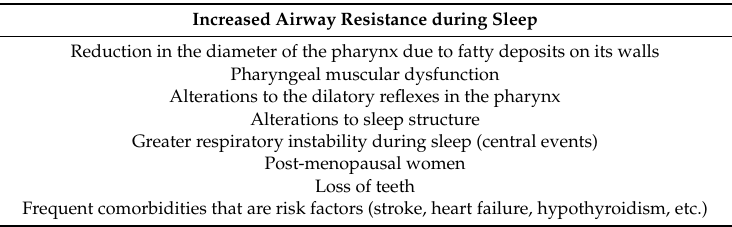
Table 1. Possible causes of greater airway collapsibility in an elderly